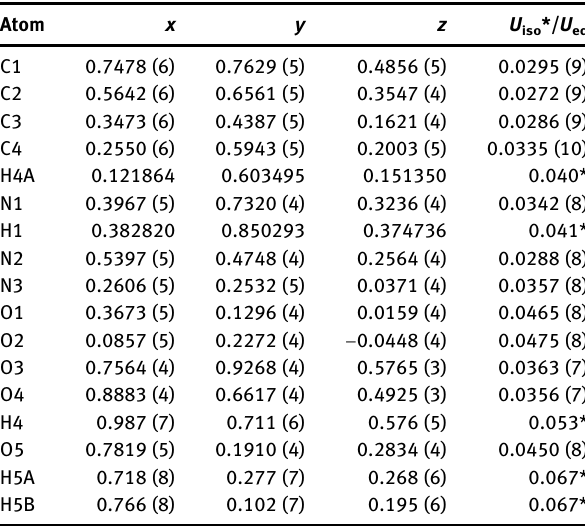
Table  : Fractional atomic coordinates and isotropic or equivalent isotropic displacement parameters (Å 